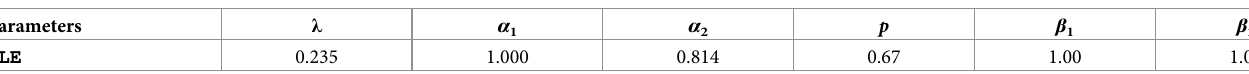
Table 2. MLE of parameters.